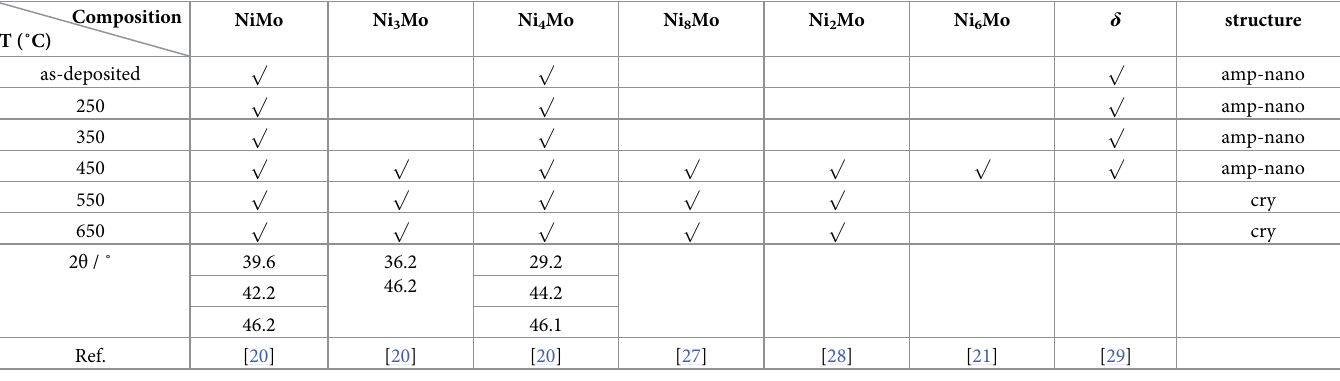
Table 1. The phase composition of the deposits after heat